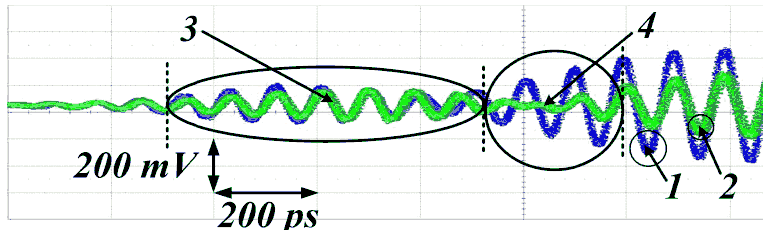
Figure 7 – Set of 2500 superimposed oscillograms of two Gunn